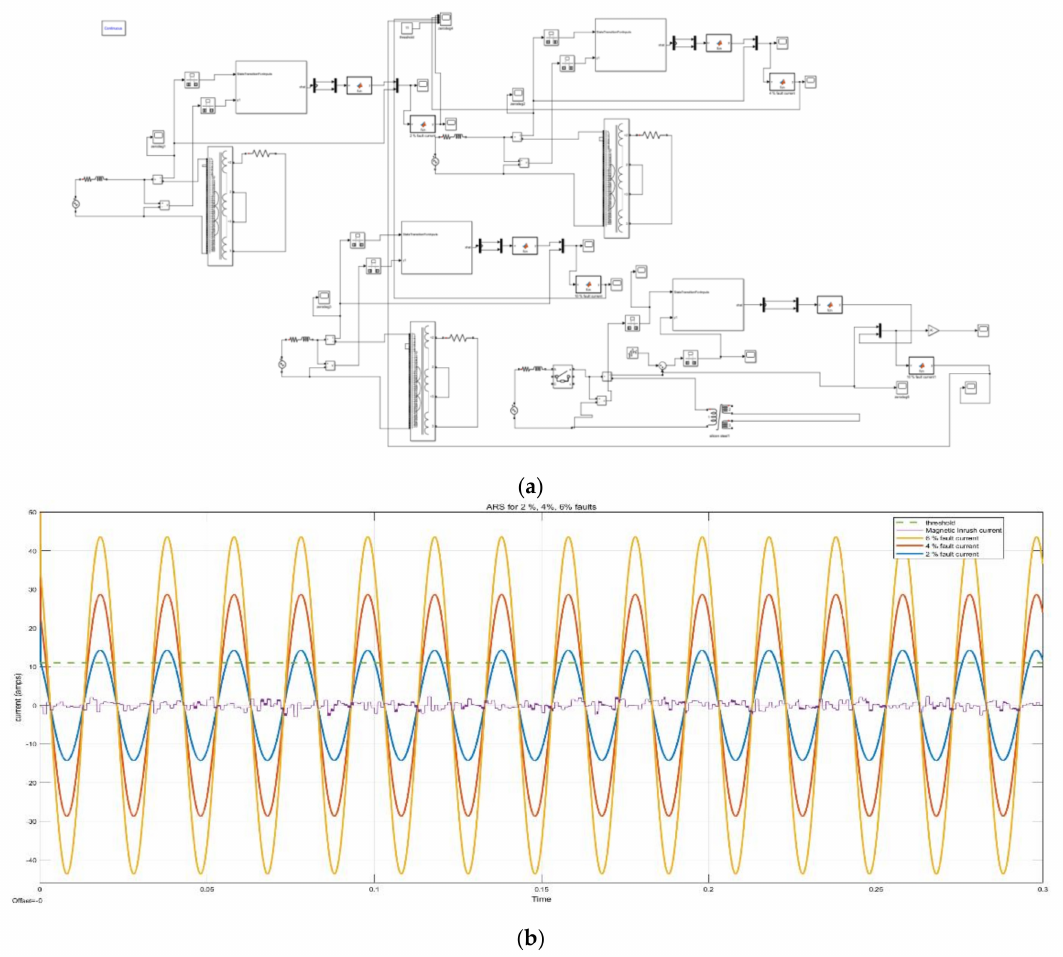
Figure 19. ( a ) Simulation model with various types of internal faults. ( b ) ARS signals of magnetic inrush current along with fault current waveforms.